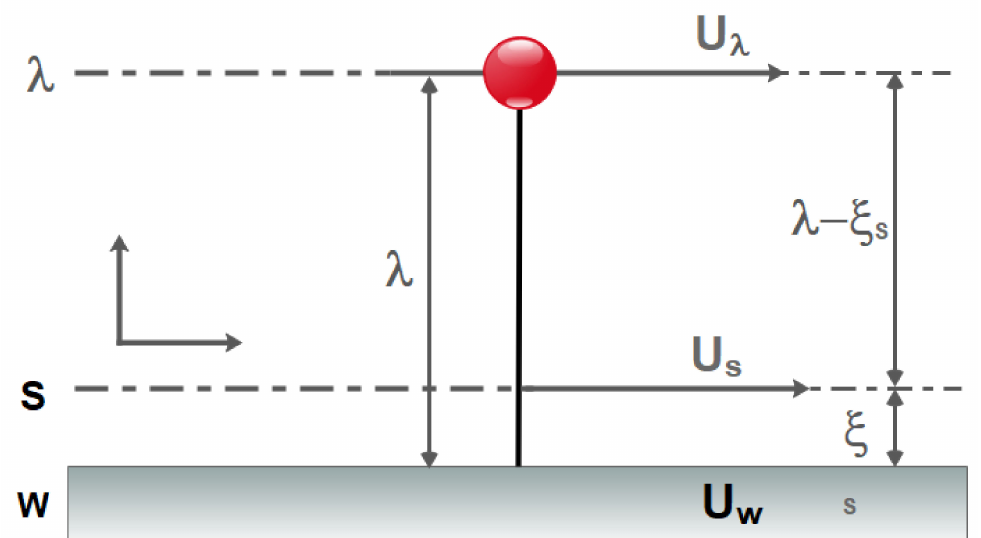
Figure 10. A schematic view of the fluid flow at the solid surface. λ represents the fluid layer one mean-free path away from the solid surface w . Surface s is the slip surface ξ s away from the solid wall and λ − ξ s away from the surface λ